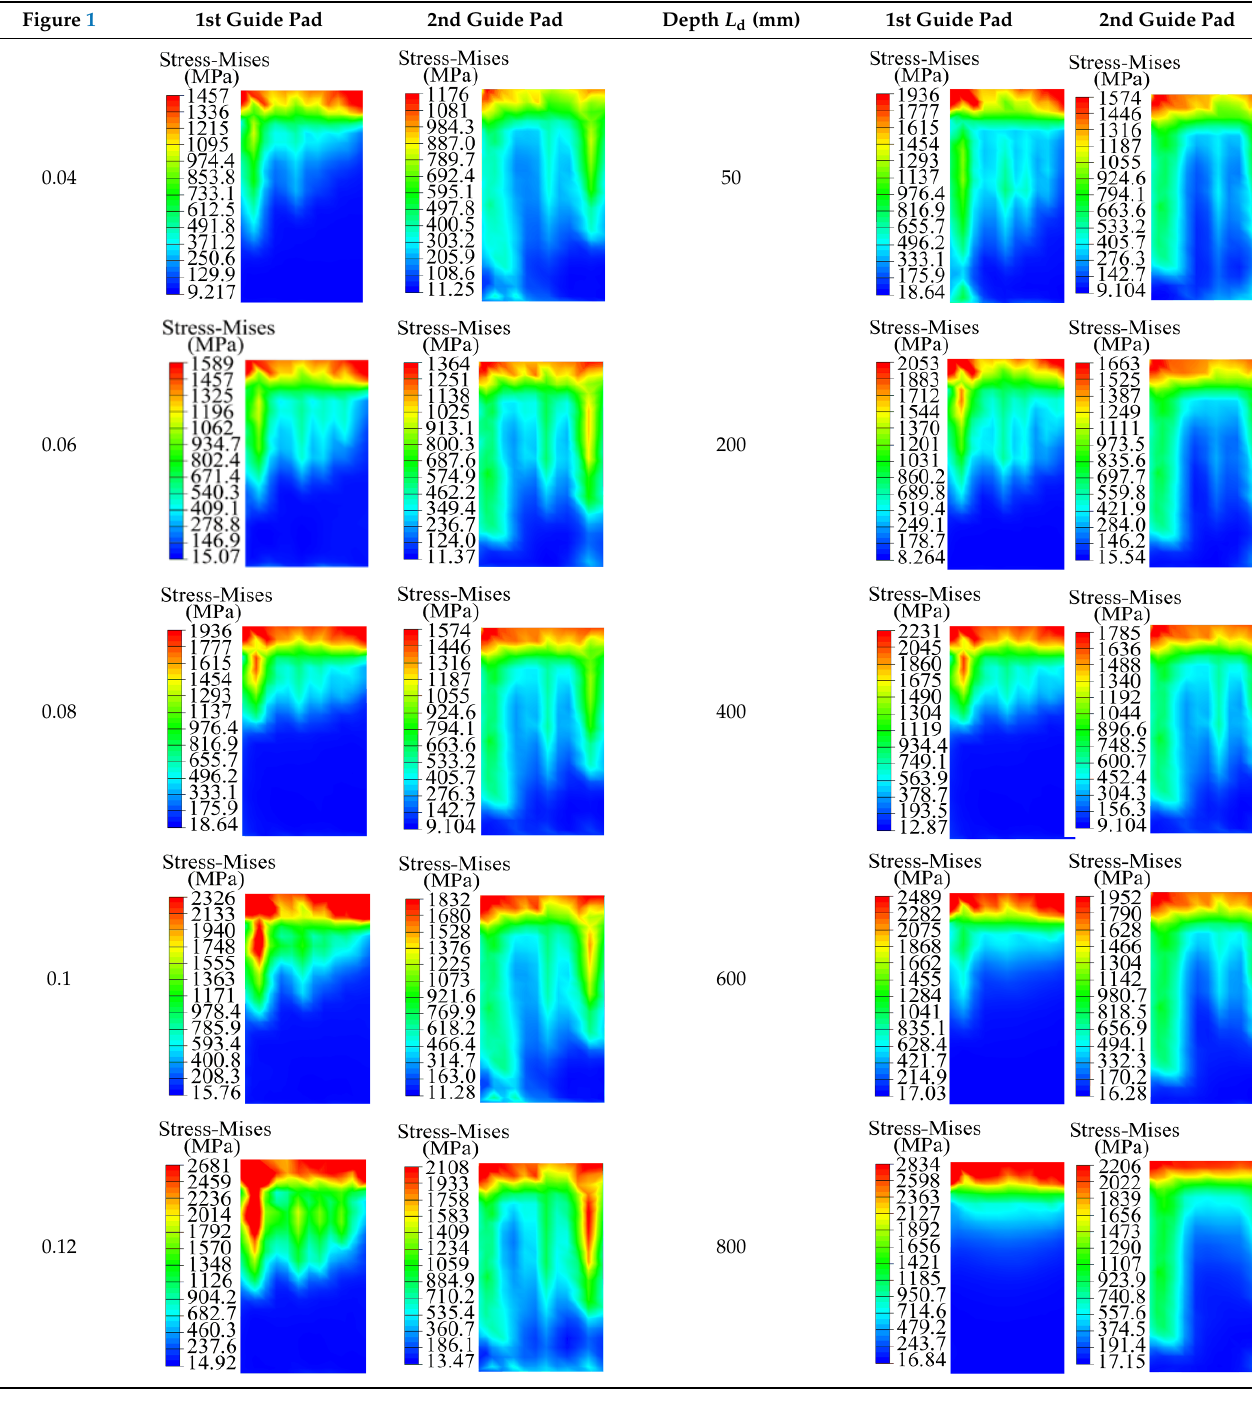
Table 3. Extrusion stress nephograms between the guide pads and hole wall under different drilling parameters. 1st Guide